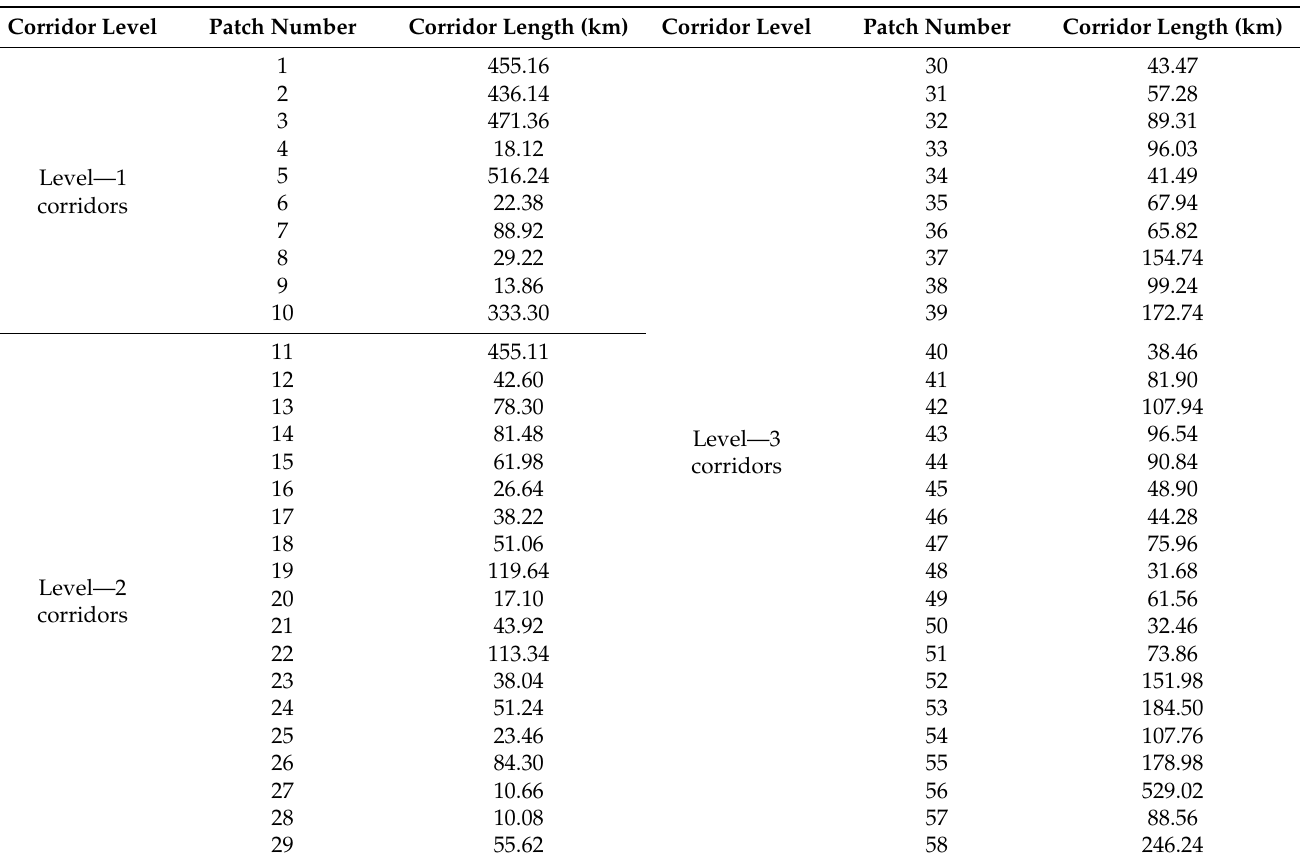
Table 7. Ecological corridor hierarchical